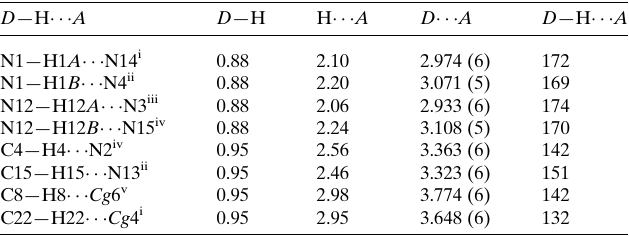
Table 1 Hydrogen-bond geometry (A˚ , (cid:3) ).